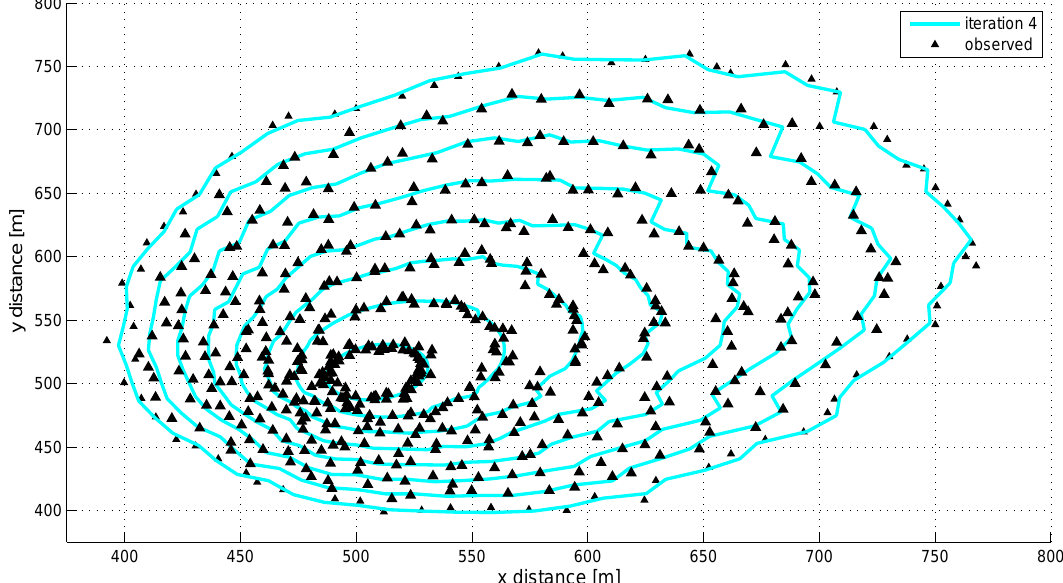
Figure 12. Perturbed fire fronts (black lines) correctly assimilated after four integrations. The invariant cast used is this of Sect. 3.5.2 where fuel depth is used as an input and three invariants are